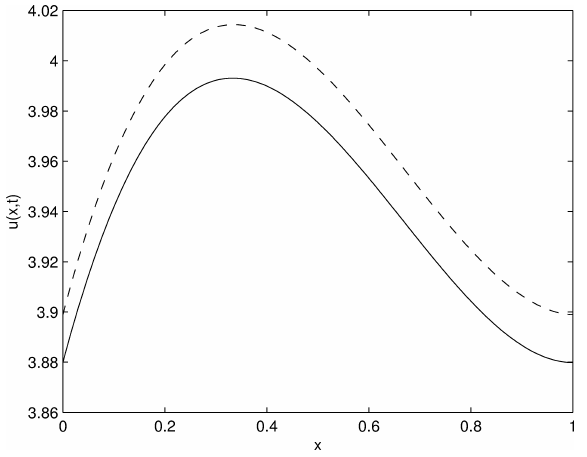
Fig. 2. The analytical and numerical solutions of u.x;t/ when T D 2 The analytical solution is shown with dashed